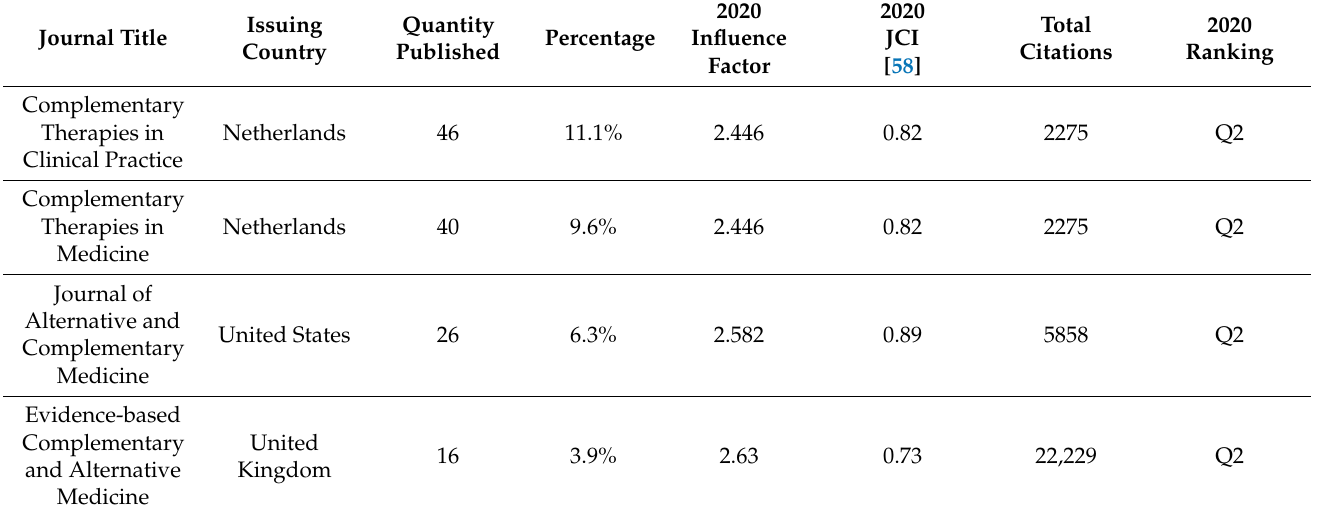
Table 1. The top 15 journals publishing the most articles on foot reflexology (in order of the total number of